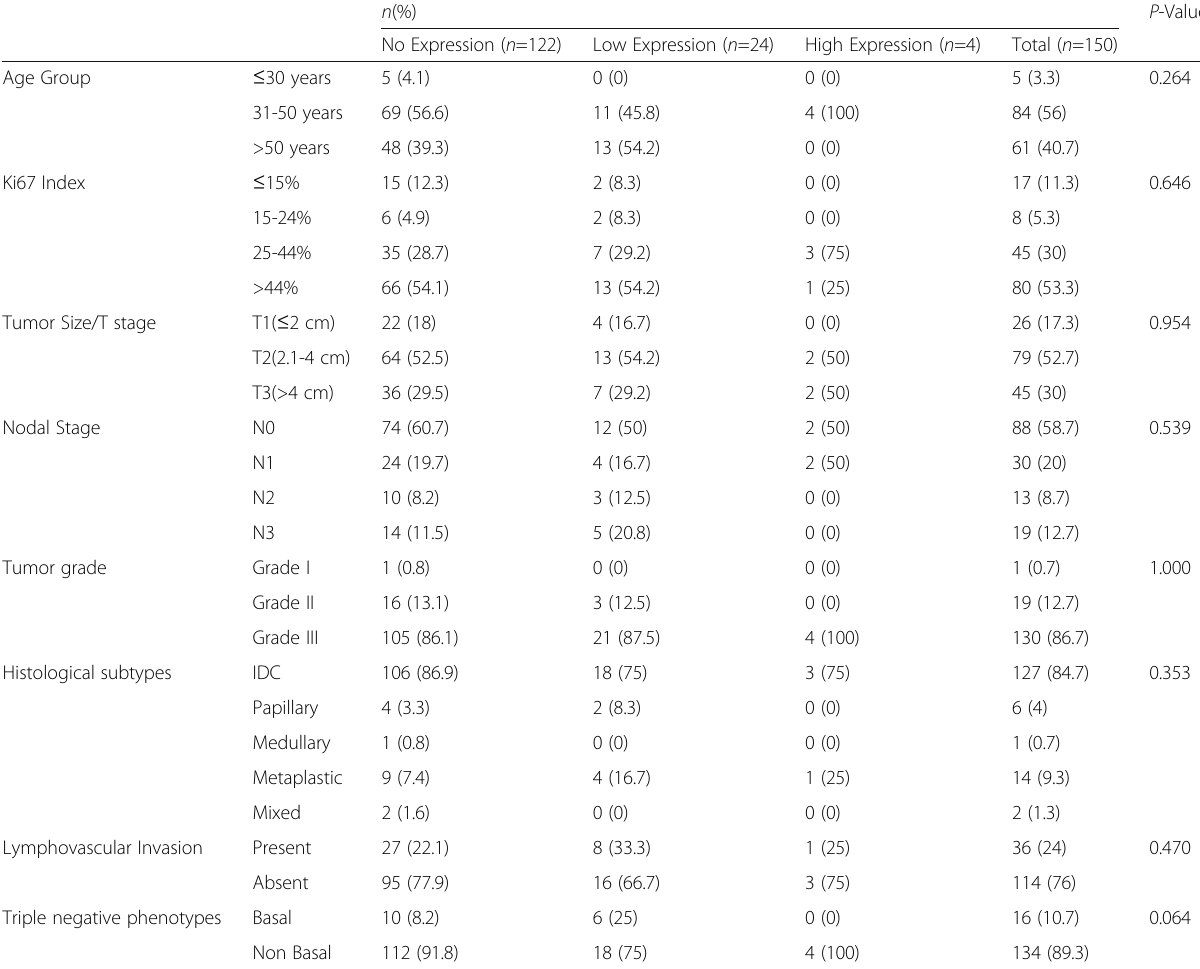
Table 1 Association of EFGR expression with clinicopathologic features of triple negative breast cancer n (%) P